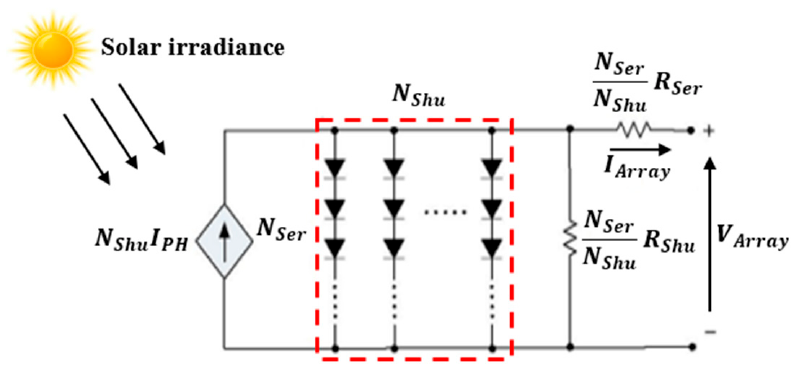
Figure 3. Equivalent PV array circuit.